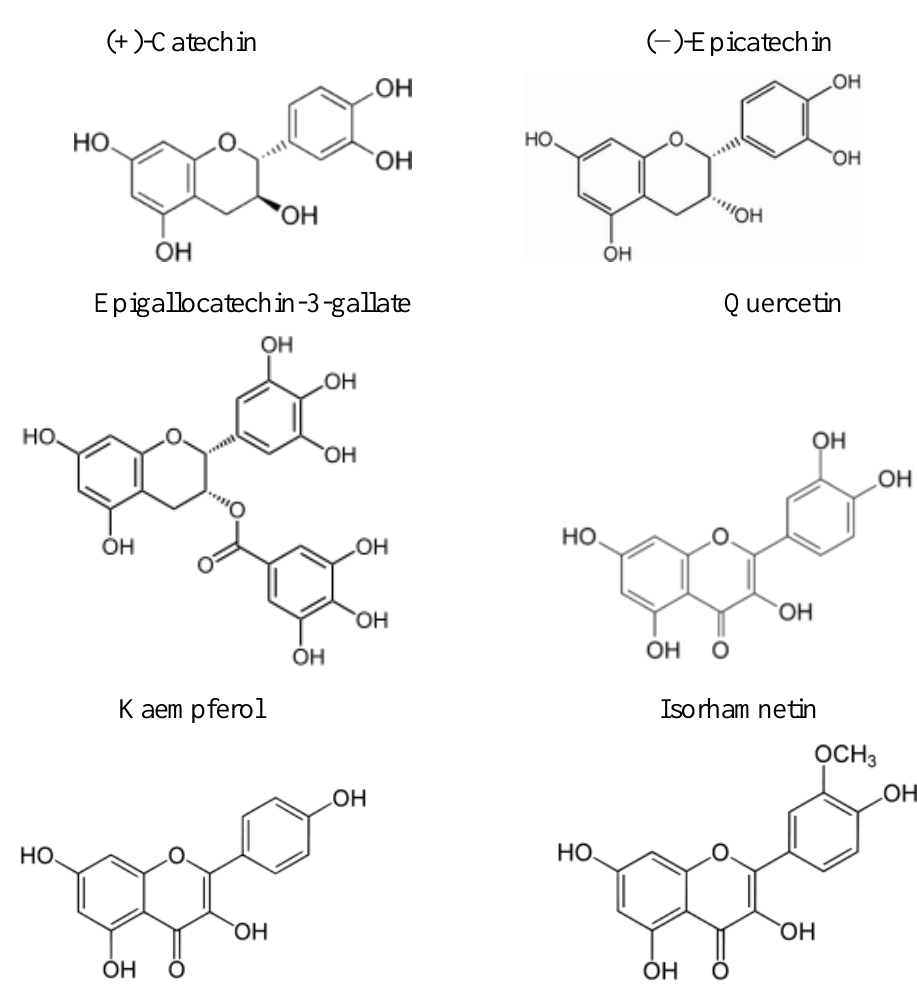
Figure 2. Chemical structure of predominant